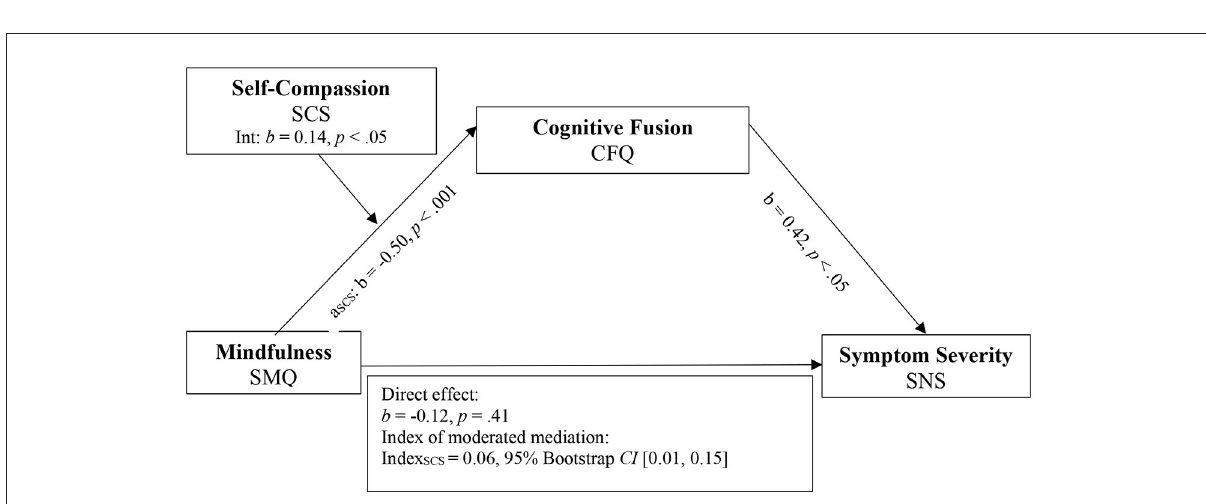
FIGURE3 Model 2. Moderated mediation model for mindfulness, self-compassion, cognitive fusion, and negative symptom severity. SMQ, Southampton Mindfulness Questionnaire; CFQ, Cognitive Fusion.